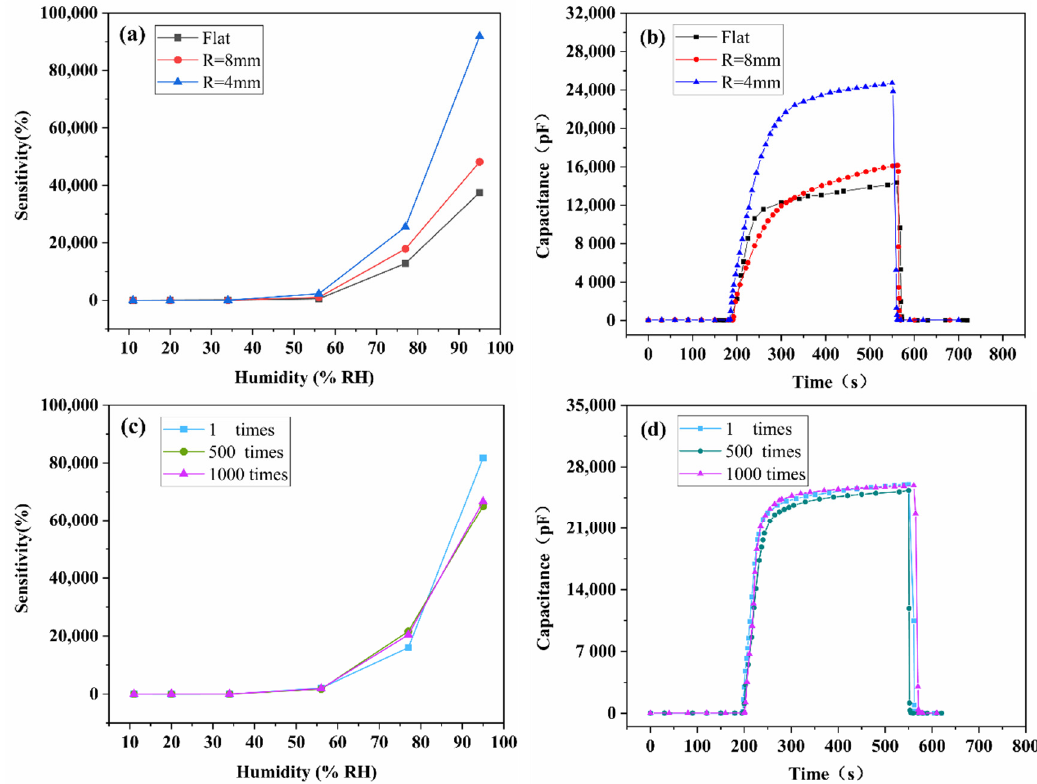
Figure 10. The influence of bending test on humidity performance of 2 wt% SnO 2 /rGO sensor. ( a ) Sensitivity and ( b ) response at different bending radius. ( c ) Sensitivity and ( d ) response after different bending times.